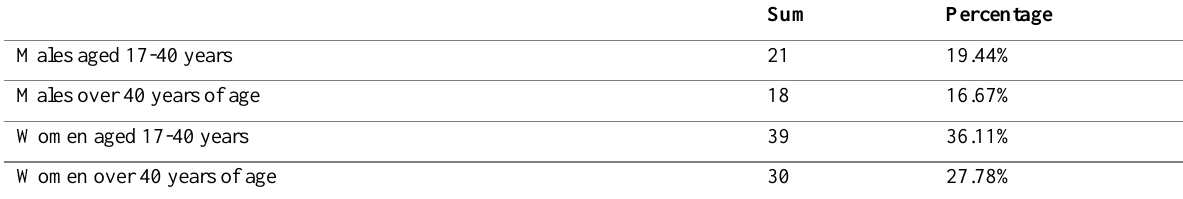
Table 1: Demographic Profiles of Respondents